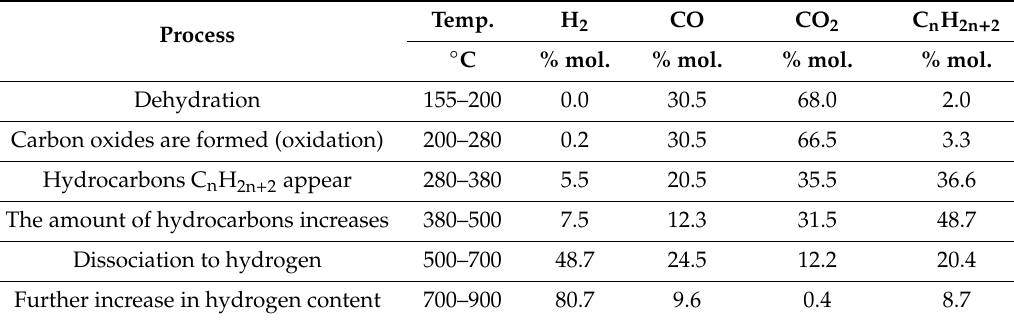
Table 5. Gas composition in free dry wood distillation as a function of temperature [17,132]. Temp. H 2 CO CO 2 C n H 2n + 2 Process ◦ C % mol. % mol. % mol. % mol. Dehydration 155–200